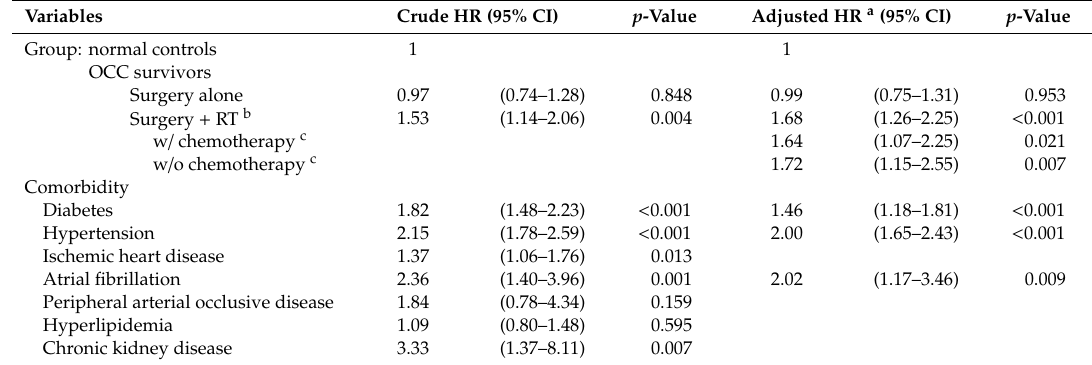
Figure 1. Cumulative incidence rate of ischemic stroke in the oral cavity cancer survivors with two treatment modalities and normal controls. Table 2. Crude and adjusted hazard ratios for the occurrence of ischemic